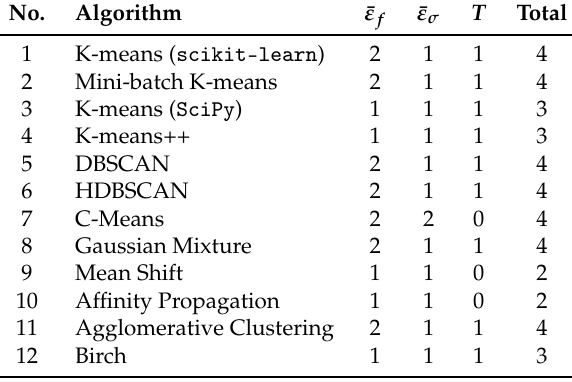
Table 2. Synthetic system: performance of the different clustering algorithms. Marks: for ¯ ε f , mark =